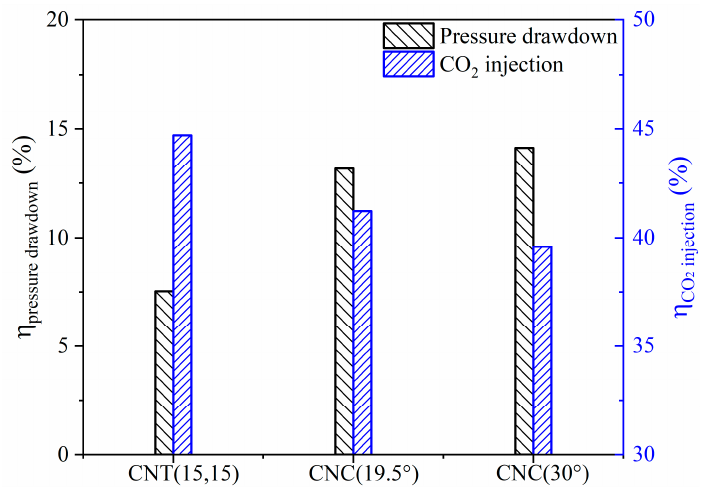
Figure 7. Relationship between pore shape and CH 4 recovery efficiency of the two different methods. T = 338 K.